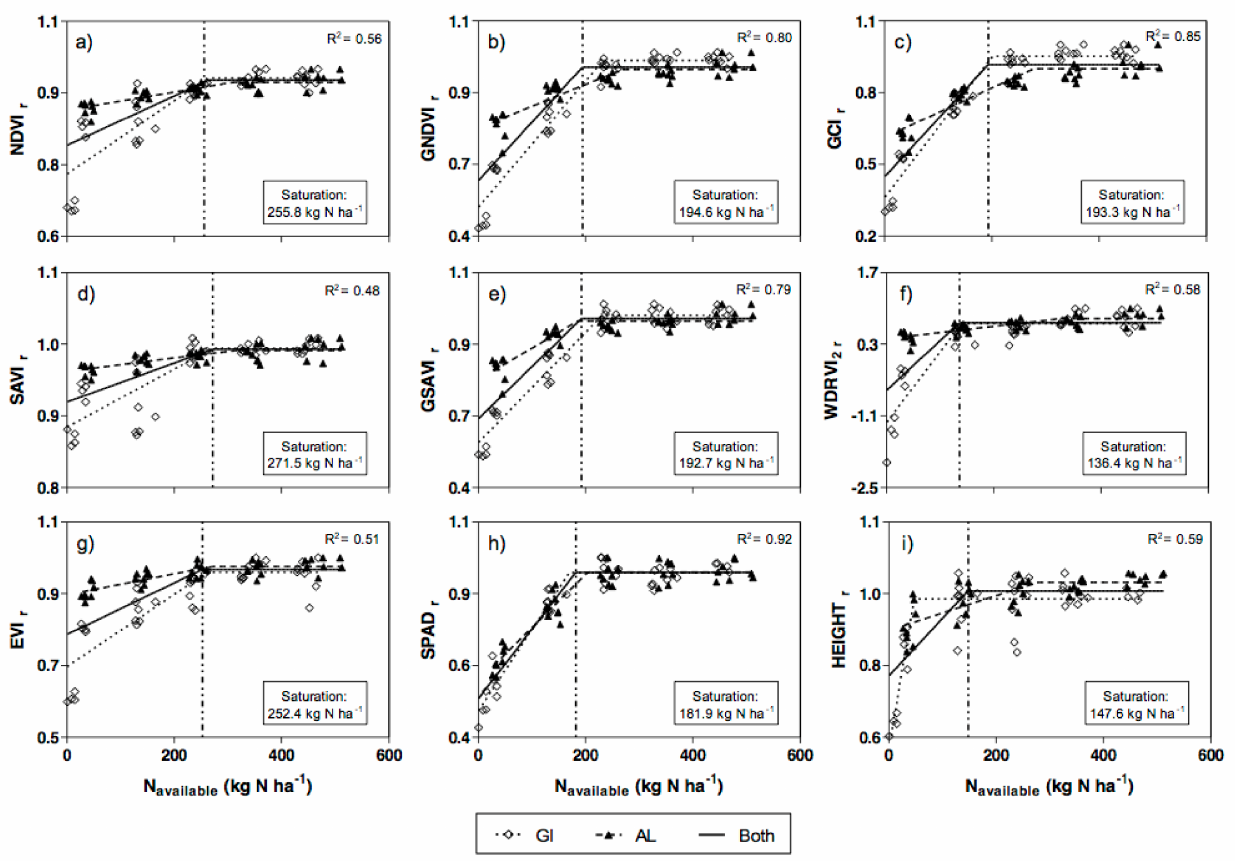
Figure 3. Response of ( a ) NDVI, ( b ) GNDVI, ( c ) GCI, ( d ) SAVI, ( e ) GSAVI, ( f ) WDRVI 2 , ( g ) EVI vegetation indices at V12 stage, ( h ) SPAD and ( i ) height at VT stage to the available nitrogen in the top soil layer (0–30 cm) (N available ) determined in the experiments. Saturation N dose was determined when there was no response to higher N fertilization. The results of Almacelles (AL) and Gimenells (GI) are presented as ratios dividing the indices values by the maximum observed in each year. ‘Both’ indicates that the two fields were analyzed